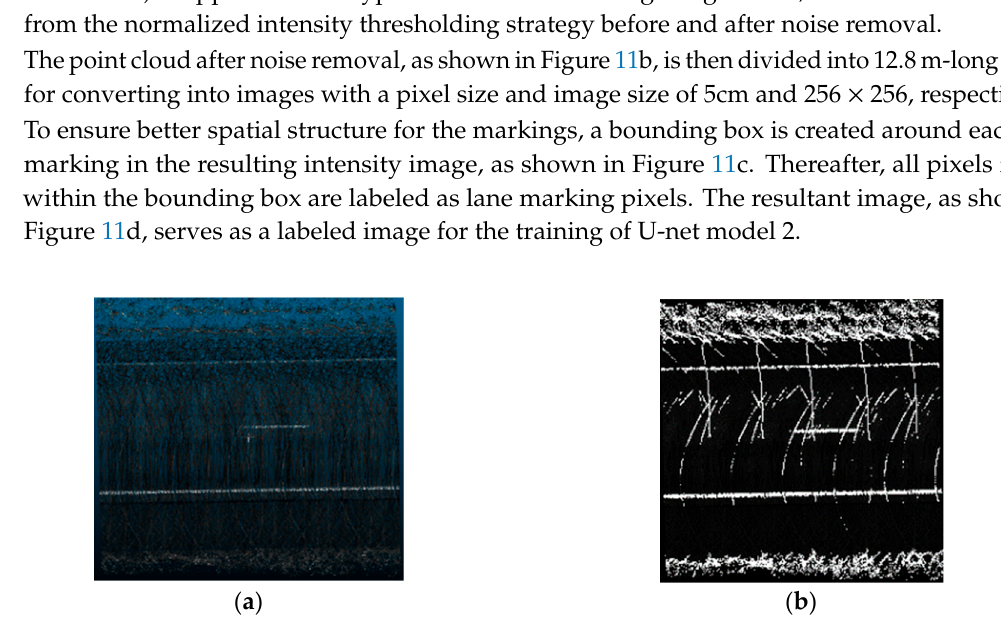
Figure 11. Illustrations of derived lane markings from ( a ) normalized intensity thresholding, ( b ) normalized intensity thresholding after noise removal, ( c ) bounding boxes (in red) encompassing lane markings, and ( d ) labeled image. U-Net Model Training